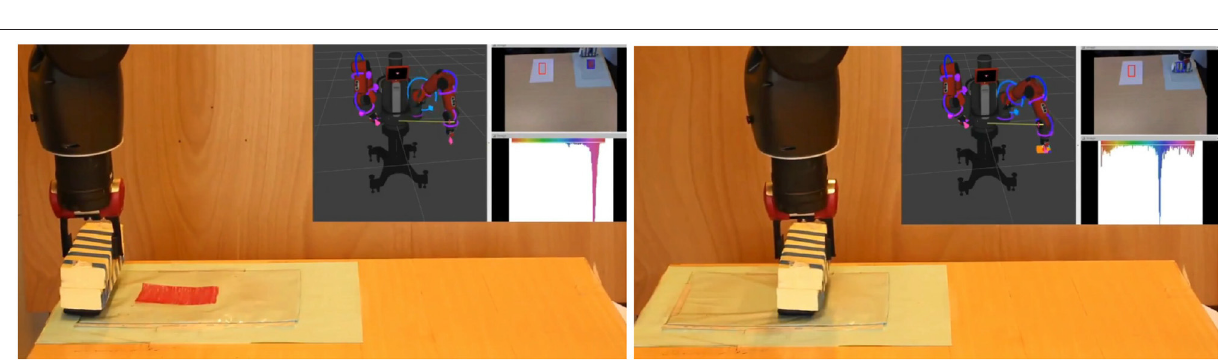
FIGURE 5 | An example of the visual perception process output. From left to right: (A) reference image (B) RGB cloud of points of the scene (C) supervoxel extraction (D) clusterization of supervoxels. For visual perception we use a Microsoft Kinect sensor that captures RGB-D data.